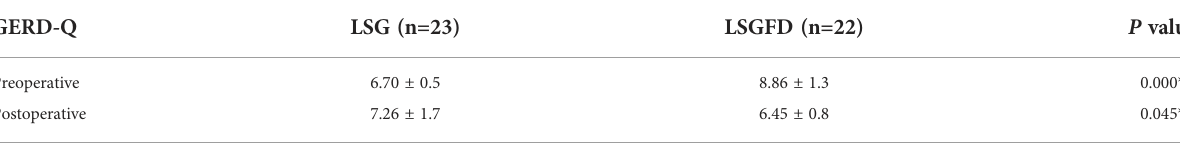
TABLE 4 (B) Comparison of preoperative and postoperative gastroesophageal re fl ux disease questionnaire (GERD-Q) scores after LSG and LSGFD. GERD-Q